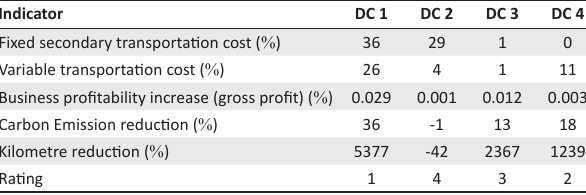
TABLE 14: Plan case study results per annum. Indicator